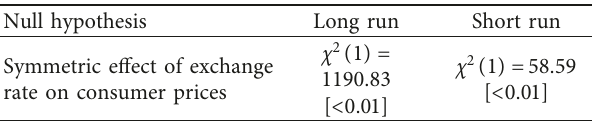
Table 5: Results of Asymmetric effects